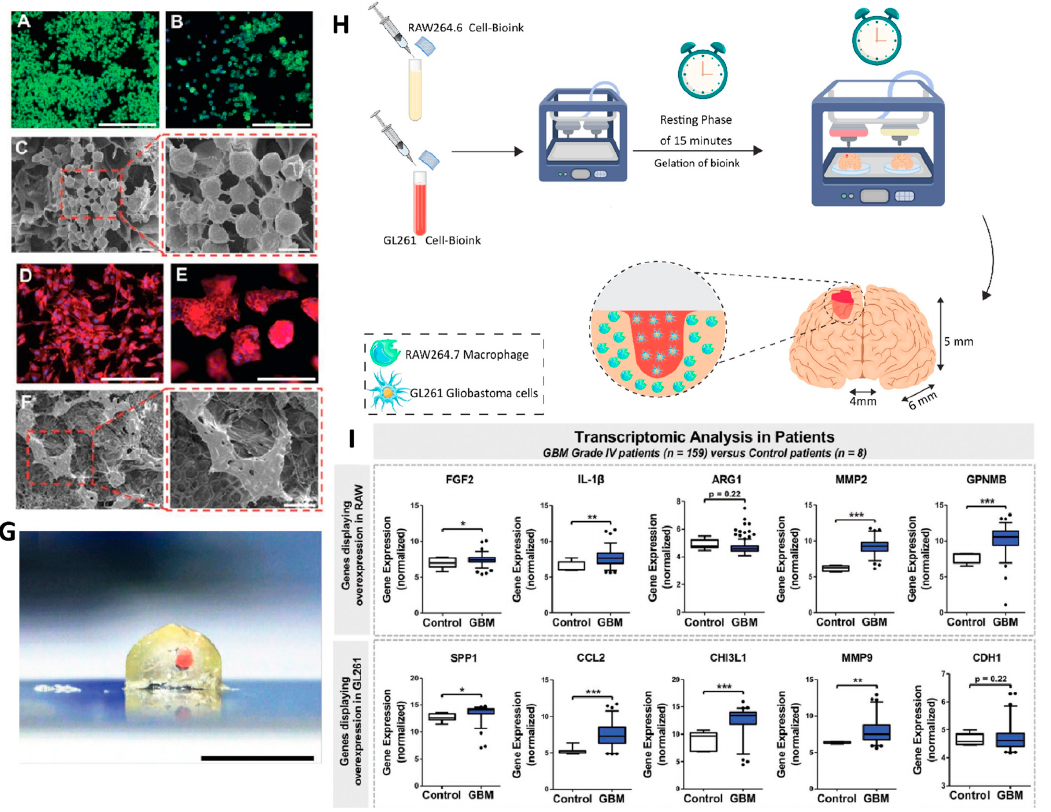
Figure 10. Fluorescence (( A , B ), scale bar= 200 µm) and SEM (( C ), scale bar= 10 µm) images of RAW264.7 macrophages (in a culture plate ( A ) and on top of the crosslinked construct ( B )). Fluorescence (( D , E ), Scale bar= 200 µm) and the SEM (( F ), Scale bar= 10 µm) images of the attached GL261 glioblastoma cells (in a culture plate ( D ) and on top of the crosslinked construct ( E )). ( G ) Cross- section of the fabricated mini-brain, in which the GBM tumor is highlighted in red (scale bar= 5 mm). ( H ) Schematic representation of the fabrication process and a cross-sectional and close-up view of the resulting mini-brain. ( I ) Results of transcriptomic analysis extracted from the public database GEO (GSE16011) for genes that are upregulated in RAW264.7 macrophages and GL261 cells (* p < 0.05, ** p < 0.01, and *** p < 0.001). Reprinted with permission from [233].